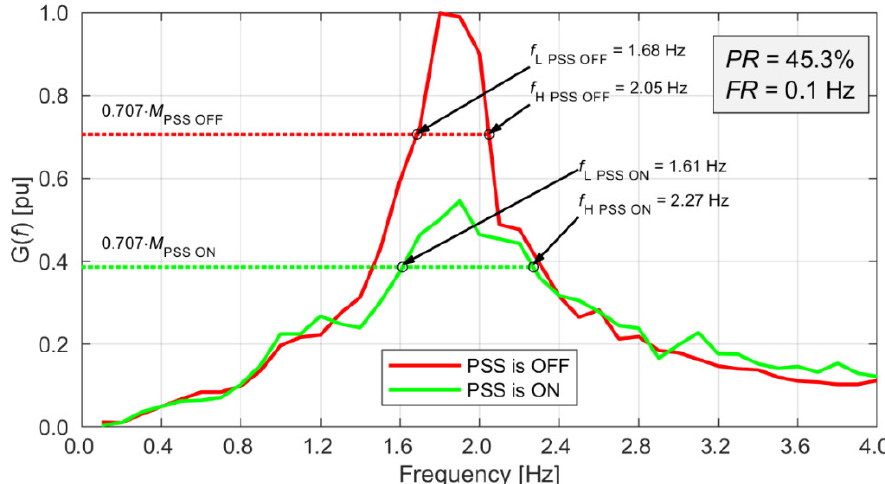
Figure 18. G PSS OFF ( f ) and G PSS ON ( f ), P g = 600 MW, Q g = 0 Mvar [45].